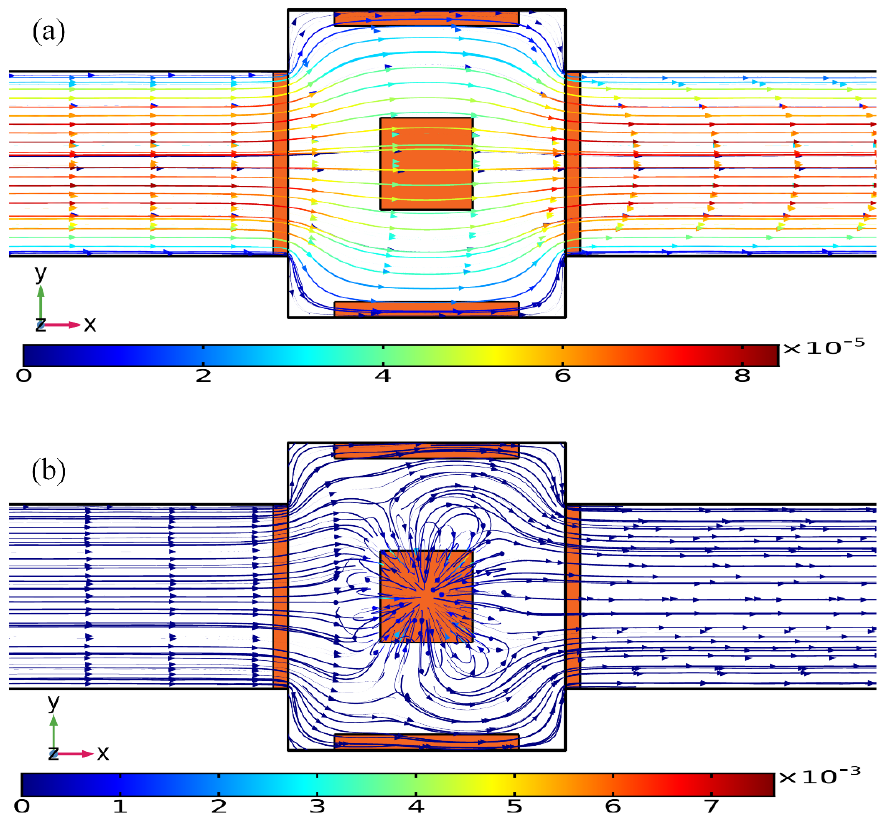
Figure 11. Influence of ROT-ICEO electroconvection on top of the central FE on the incoming laminar stream under the dynamic condition, when the driving voltage amplitude is ( a ) V 0 = 0 V, and ( b ) V 0 = 8 V at f = 200 Hz with an average inlet flow rate of 50 um/s (unit: m/s).